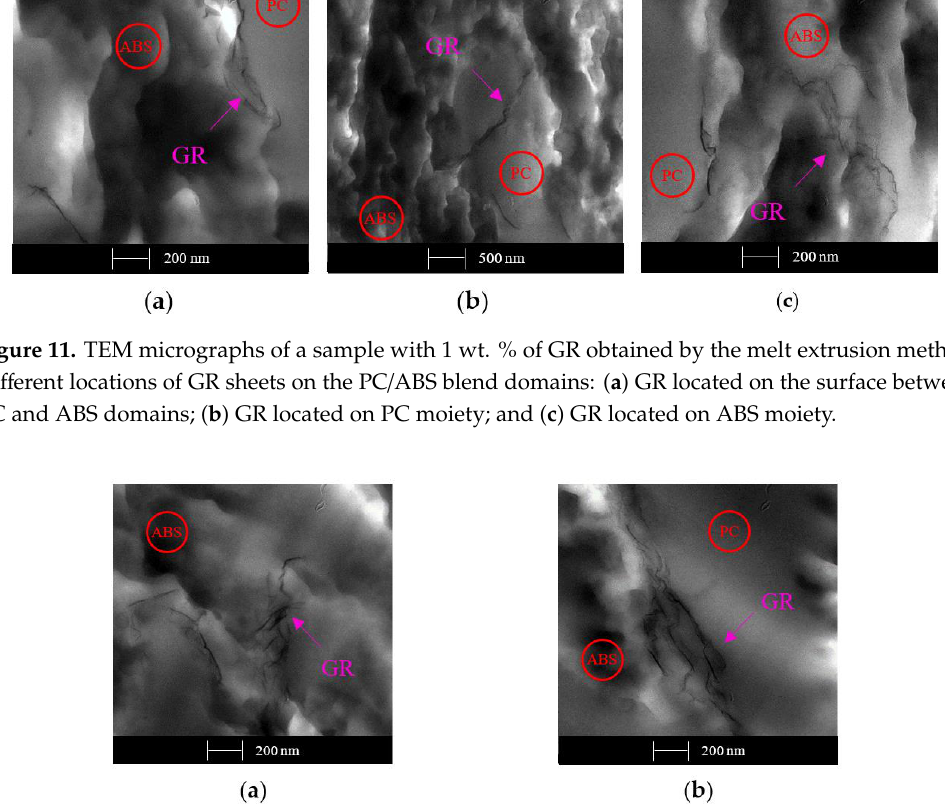
Figure 12. TEM micrographs of samples with 1 wt. % of GR obtained by solution dispersion methods: ( a ) with solvent removal by evaporation; ( b ) with solvent removal by